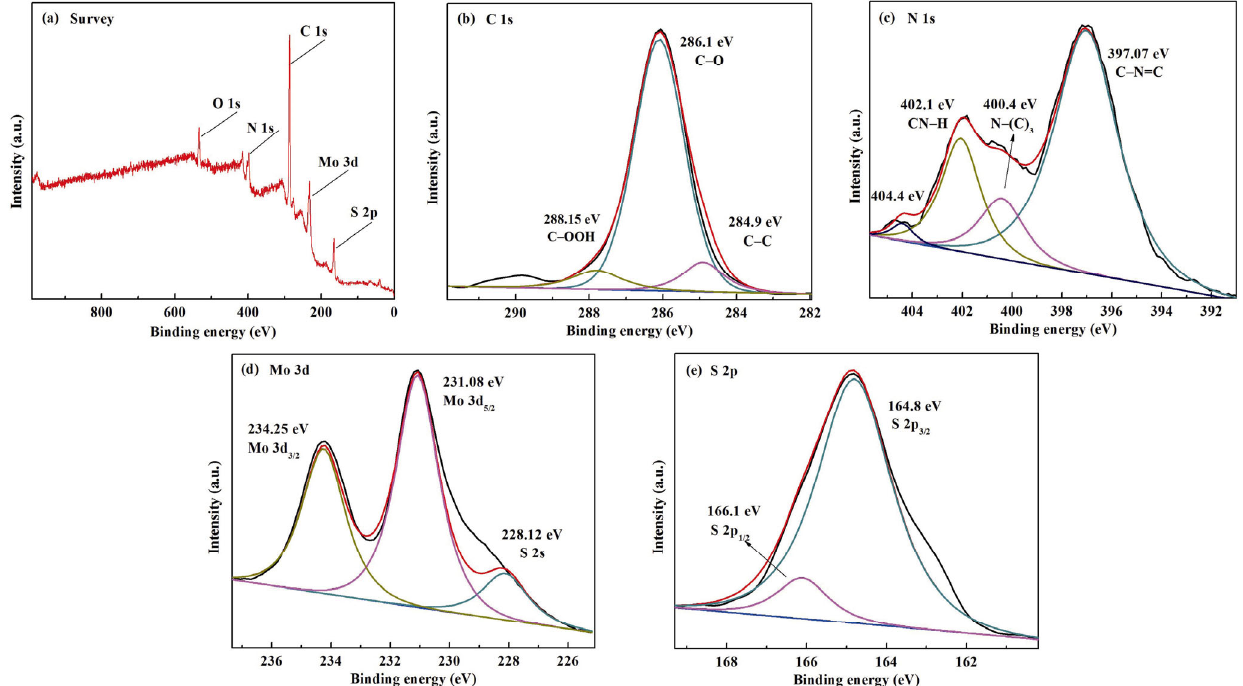
Fig. 3 XPS spectra of C 1s, N 1s, Mo 3d, and S 2p peaks of CN/MoS 2